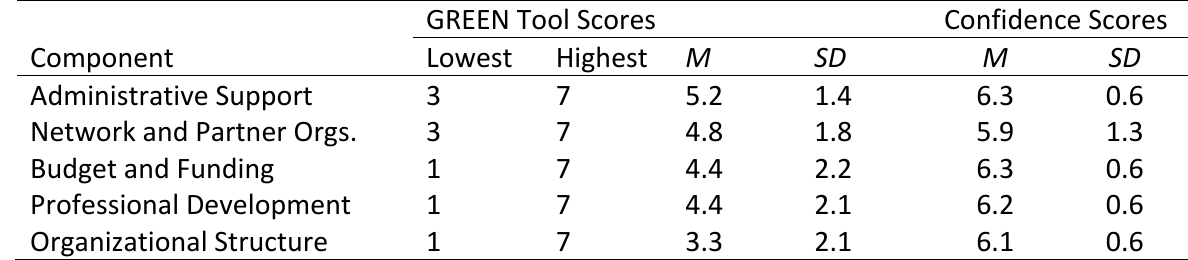
Summary and Comparison of GREEN Tool and Confidence Scores for Domain 1 (n = 15) GREEN Tool Scores Component Administrative